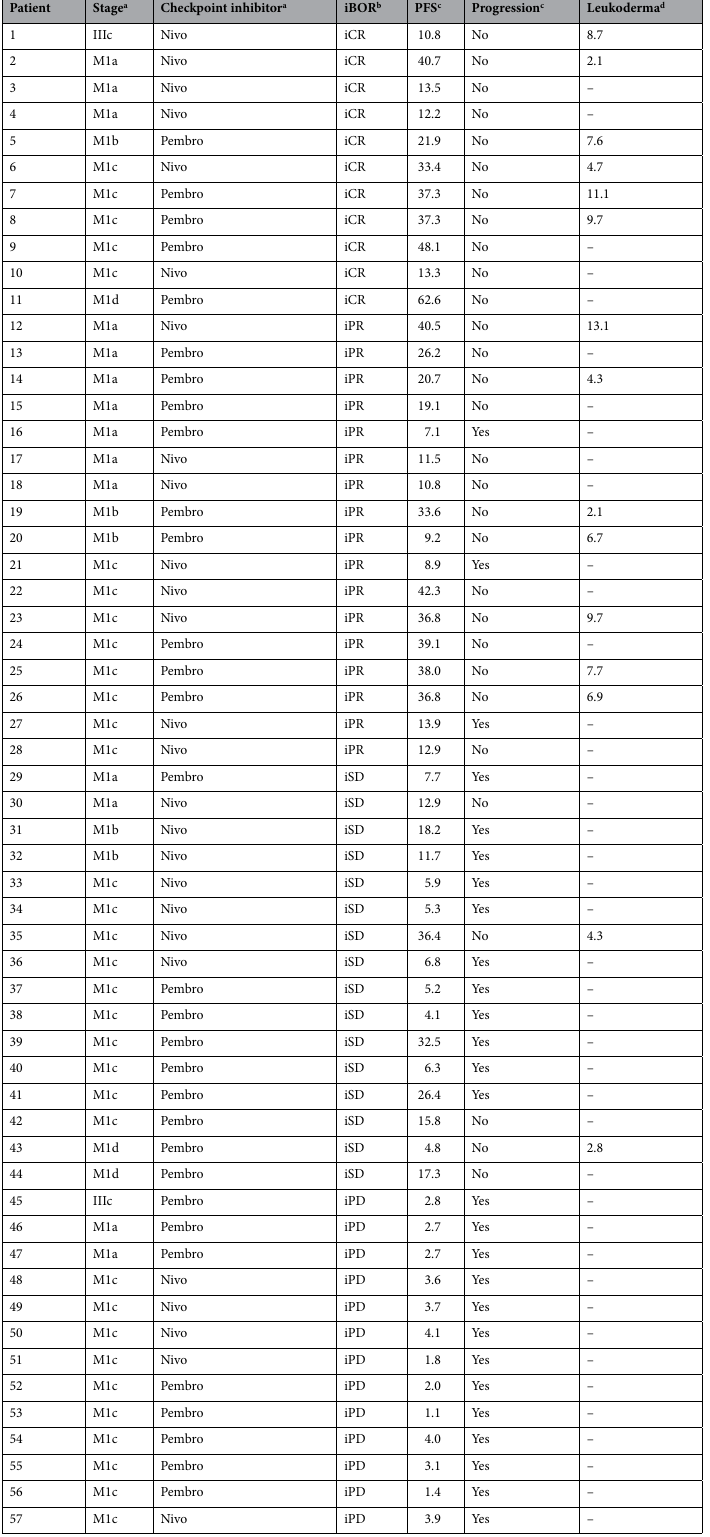
Table 1. Characteristics and treatment outcomes of enrolled patients. a Staging before starting therapy: nivo, nivolumab; pembro, pembrolizumab. b iBOR, best overall response according to the iRECIST criteria: iCR, complete response; iPR, partial response; iSD, stable disease; iPD, progressive disease. c Data cut off on 11th November 2020. PFS, progression-free survival (months). d Patients who had developed (months) or not (–) leukoderma at the cut off